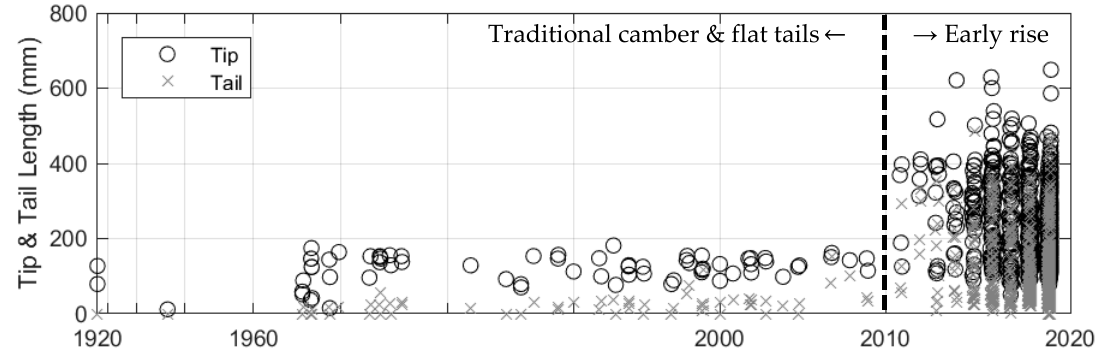
Figure 5. Waist width vs. model year.